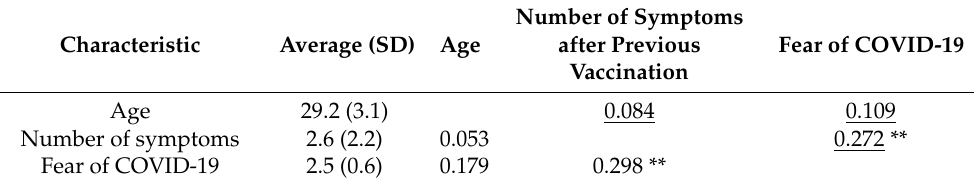
Table 3. Correlations between fear of COVID-19, age, and number of symptoms after previous vaccination.